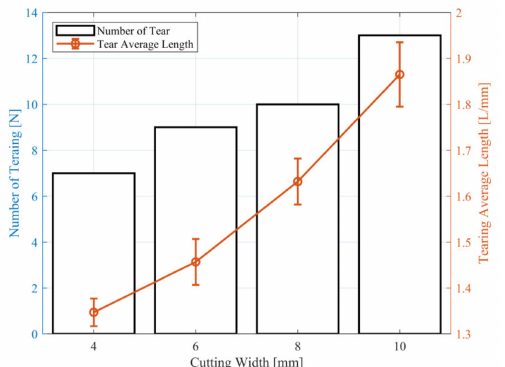
Figure 20. The effect of tool cutting width on surface morphology.